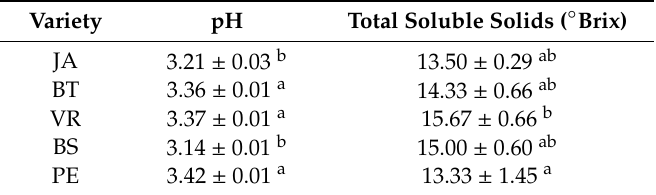
Table 2. Determining pH and total soluble solids (TSS) content of fresh